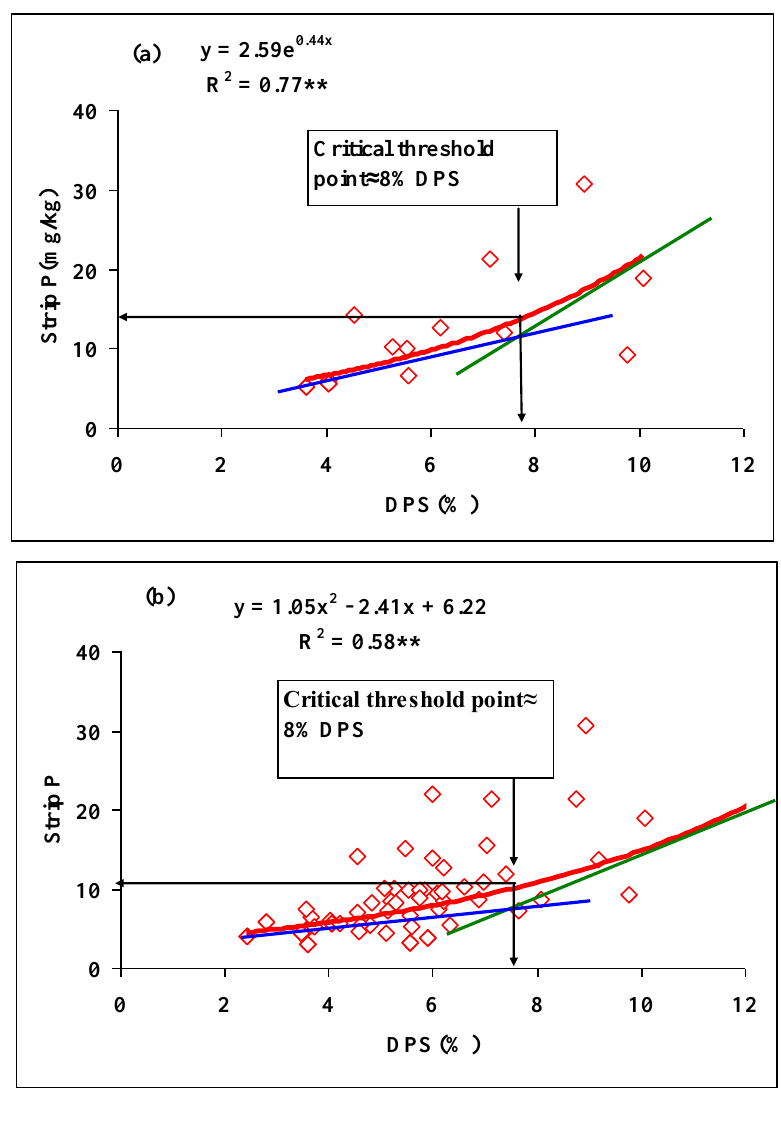
FIGURE 6. Relationship between (a) initial strip P vs. initial DPS (the first determined 2 months after treatment application); (b) average strip P (determined in five samplings) vs. average DPS determined for the five samplings. Note: the blue and green lines in a and b are the tangents for the lower and upper slopes, respectively. The point where the two intersect is considered the change point of the slope and the corresponding strip P is the critical P